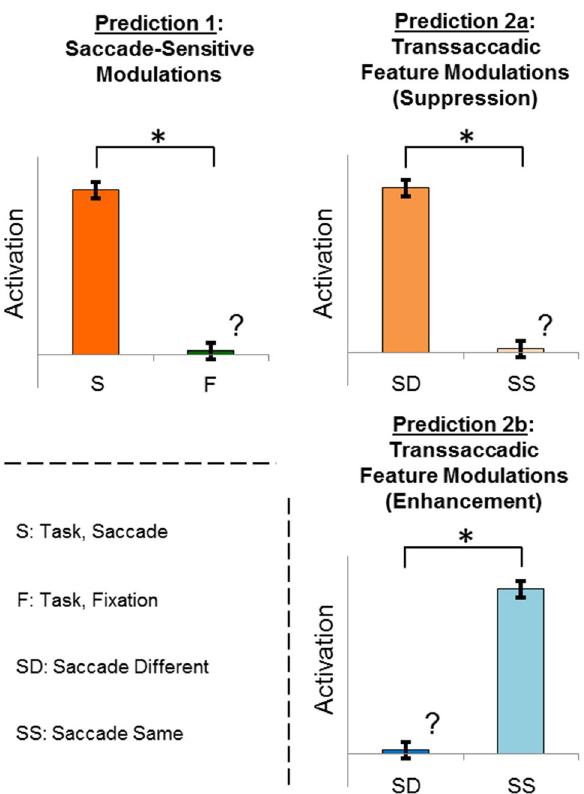
Figure 2. Predictions used to test saccade- and feature-specificity. Prediction 1: The saccade-related effects in this region should be larger in the Saccade condition than the Fixation condition, within the experimental task (i.e., (Saccade – Fixation); S, F, respectively). Prediction 2a: Parietal areas should show transsaccadic feature repetition suppression 21,25 , i.e., a larger response for a change in spatial frequency than a repetition, following an intervening saccade (i.e., (Saccade/Different > Saccade/Same); SD, SS, respectively). Prediction 2b: Alternatively, occipital areas have been known to show transsaccadic repetition enhancement 21 , whereby there should be a larger response for a repetition in spatial frequency than for changes, following an intervening saccade (i.e., (Saccade/Same > Saccade/Different)) (Microsoft PowerPoint v16.44; www. micro soft.